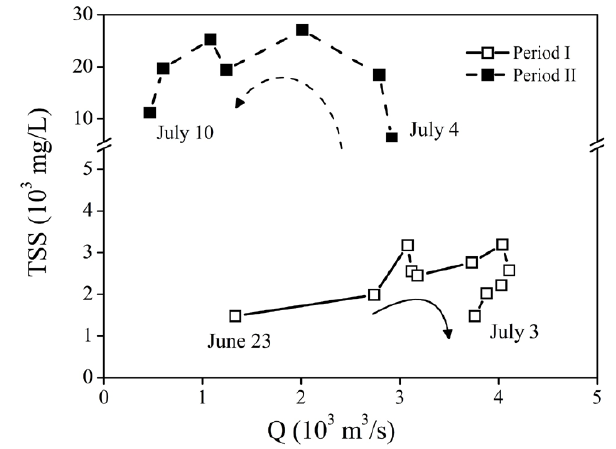
Fig. 7. Relationship between discharge ( Q ) and TSS in the water release period (period I) and the sediment release period (period II) during the 2008 water and sediment regulation period at the Lijin